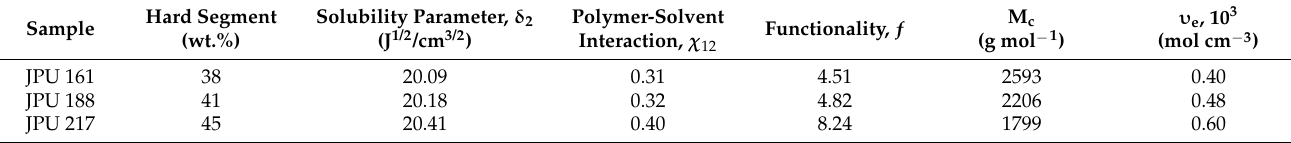
Table 4. Crosslinking density, molecular weight between crosslinks and solubility characteristics of the JPU films in toluene. Hard Segment Sample (wt.%)